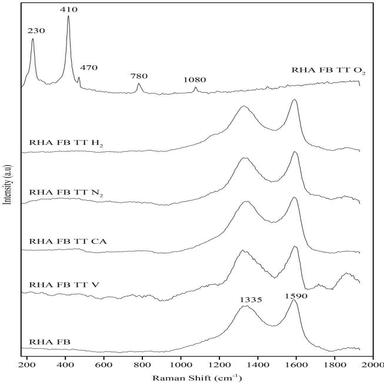
Raman spectroscopy of the different heat treatments performed for RHA FB.